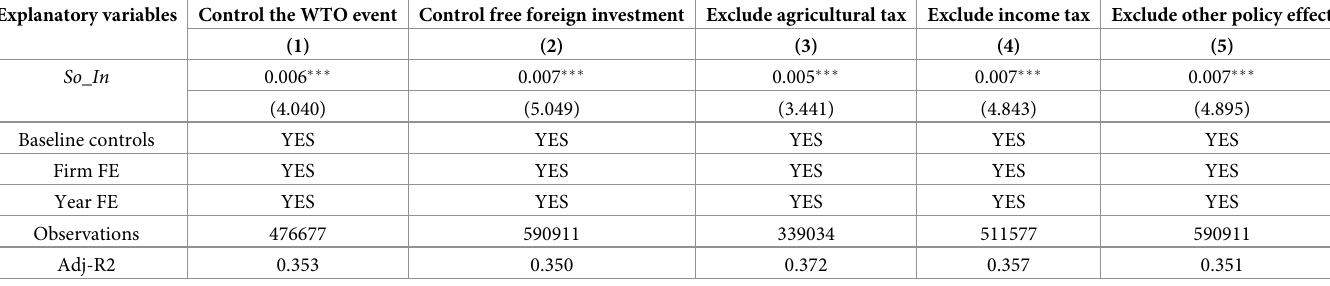
Table 7. Robustness Test